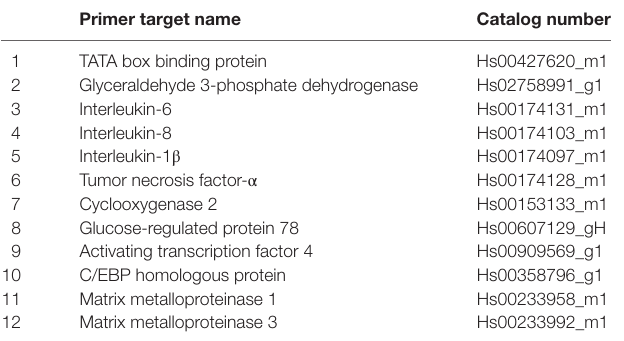
TaBle 1 | Human TaqMan primers used in the